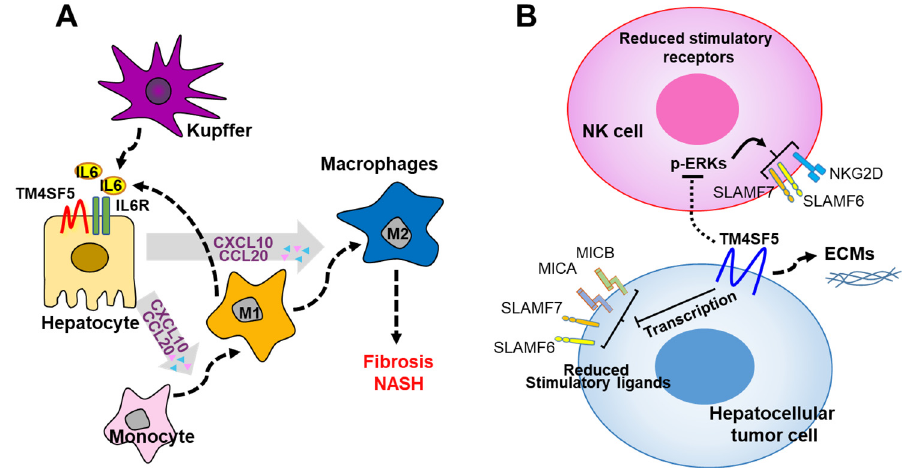
Figure 4. Working model for TM4SF5-dependent crosstalk between hepatocytes and immune cells during nonalcoholic fatty liver disease progression. ( A ) TM4SF5-dependent M1-type MF polarization and activation results in the secretion of proinflammatory cytokines, such as IL-6, which, in turn, enhances the expression of CCL20 and CXCL10 in TM4SF5-positive hepatocytes. Eventually, via chronic bidirectional crosstalk, reprogramming of M1-type MFs to M2-type MFs can occur during the progression to fibrosis and hepatocellular carcinoma. ( B ) High expression of TM4SF5 in liver cancer cells downregulates stimulatory immune checkpoint ligands and receptors on hepatocytes and NK cells, respectively, eventually leading to inhibited NK cell cytotoxicity. The downregulation of the stimulatory ligands and receptors may be achieved at the transcriptional level, since mRNA levels in NK cells depending on hepatocyte TM4SF5 expression are reduced in parallel with intracellular ERK1/2 signaling activity [13]. Alternatively, the modulation of the expression levels may also be a matter of protein stability according to TM4SF5-mediated associations and intracellular translocalization. IL6, interleukin 5; CCL20, C-C motif chemokine ligand 20; CXCL10, C-X-C motif chemokine ligand 10; MICA and MICB, MHC class I chain-related protein A and B; SLAMF6 and 7, signaling lymphocyte activation molecule 6 and 7; NKG2D, NKG2-D-activating NK receptor; IL6R, IL6 receptor; TM4SF5, transmembrane 4 L six family member 5.